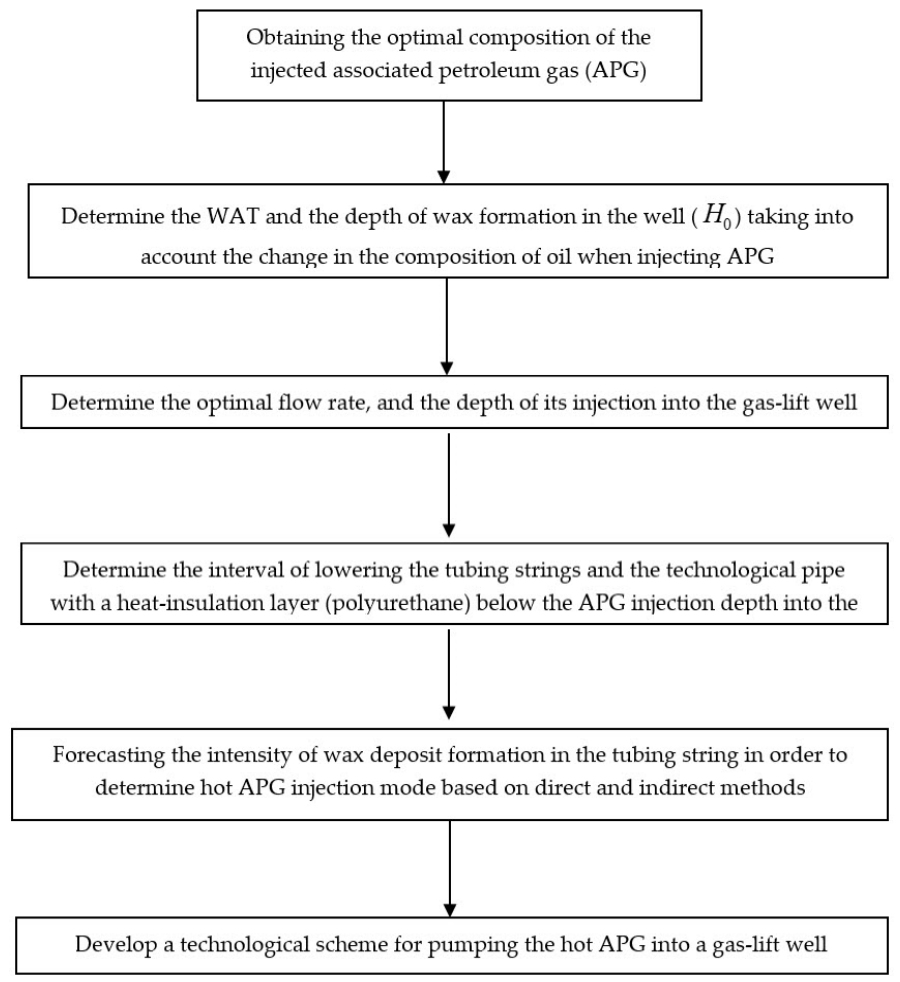
Figure 2. Diagram of the proposed technology.